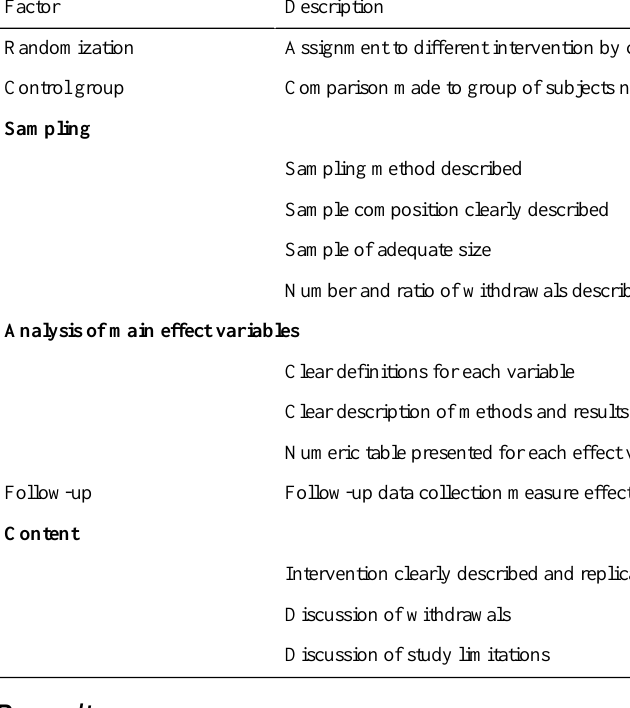
Table 1. Rating system as adapted by Fry and